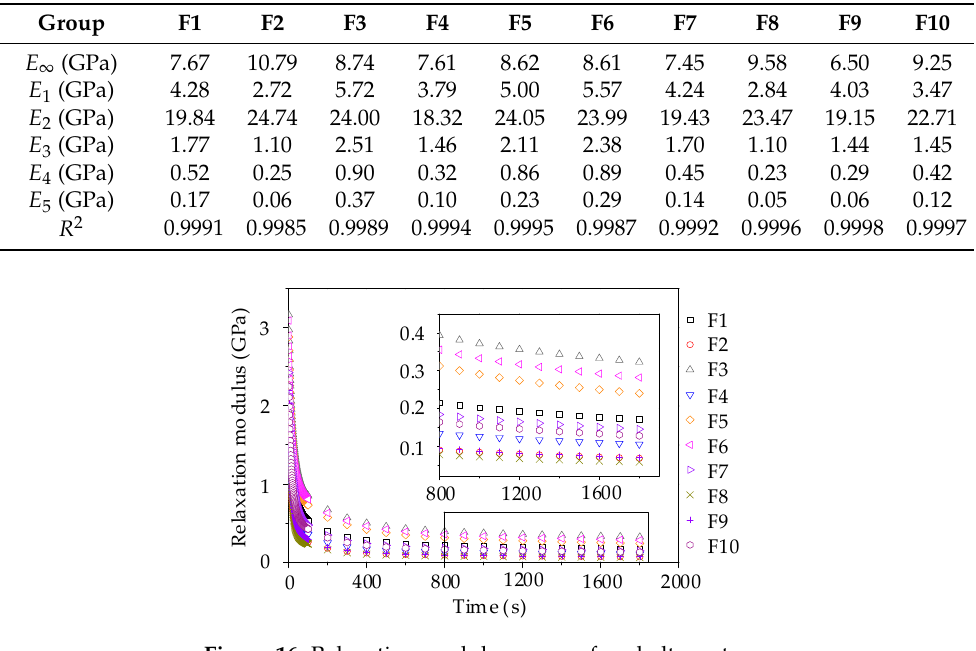
Figure 16. Relaxation modulus curve of asphalt mortars.